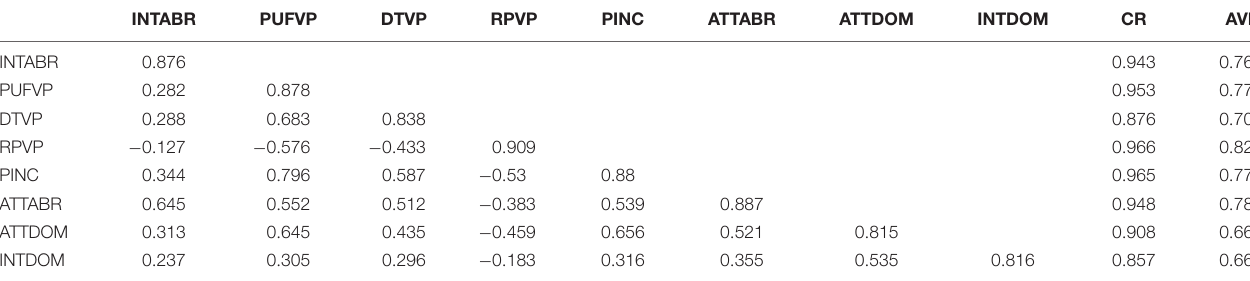
TABLE 4 | Results of measurement model and